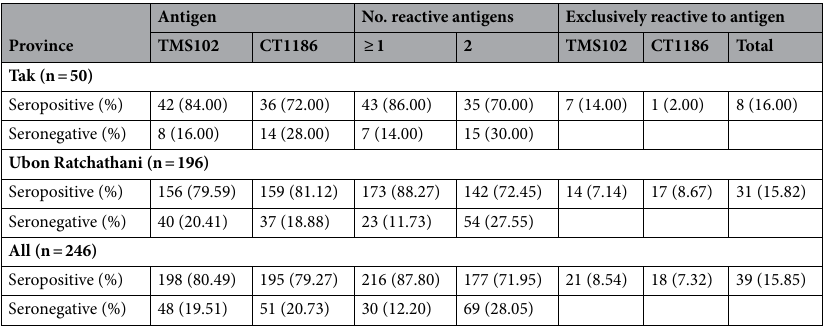
Table 1. Prevalence of IgG antibodies to the N-terminal domain of PvMSP9 among P. vivax -infected Thai